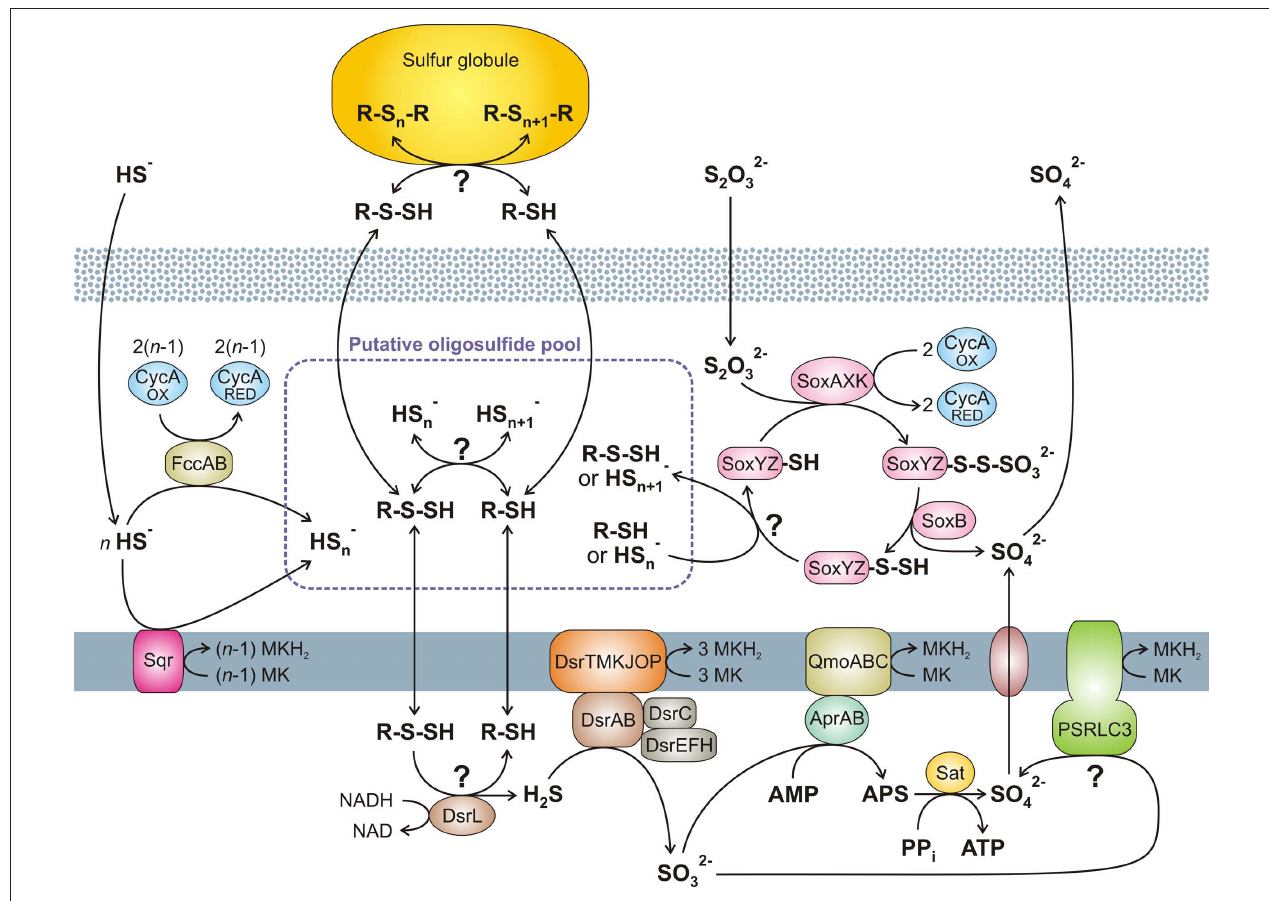
Figure 1 | Overview of the putative pathways of oxidative sulfur metabolism in gSB. All oxidative enzyme systems shown in the periplasm (SOX, SQR, and FCC systems) as well as extracellular sulfur globules contribute to a putative pool of oligosulfides (HS n − and possibly organic R-S